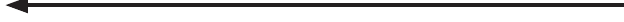
Figure 2 Hypoosmotic or hyperosmotic Src family kinase